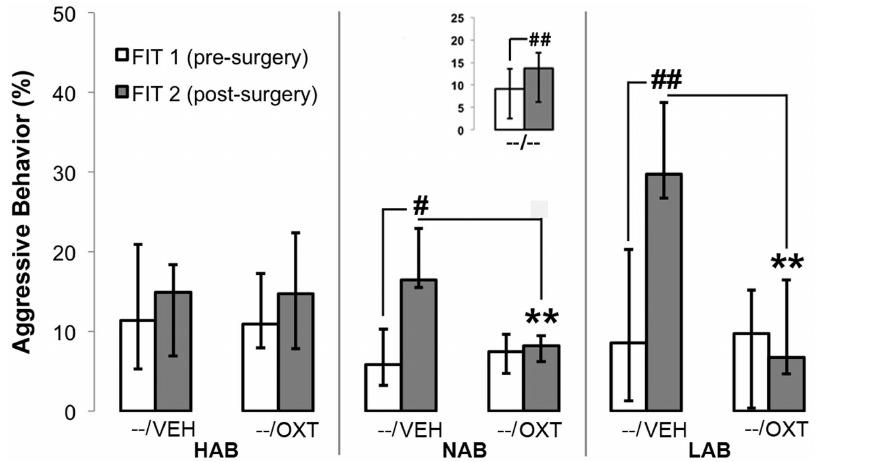
Figure 4. Percentage of aggressive behavior of adult (10–11 week old) virgin female HAB, NAB and LAB rats in two 10-min FITs, five days prior to surgery (FIT 1) or two days after surgery (FIT 2). 20 min prior to FIT 2, rats were ICV infused with either VEH (5 m l Ringer, n=10 per selection line) or OXT (0.1 m g/5 m l Ringer, n=10 per selection line). Insert shows data for unmanipulated NAB rats (no surgery performed, n=24). **Significant difference with corresponding VEH data (p , 0.01). # / ## Significant difference with corresponding FIT 1 data ( # p=0.06, ## P ,